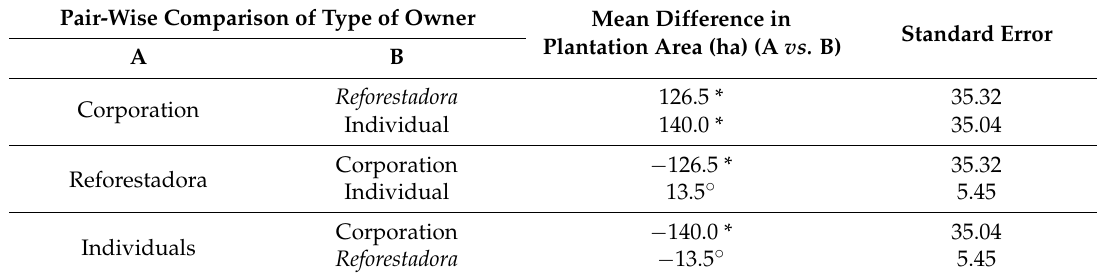
Table 6. Post hoc test on ANOVA of plantation area by corporate, local commercial and individual plantation owners, Greater Bayano Region,